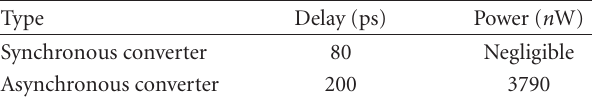
Table 2. The usage of function units and level